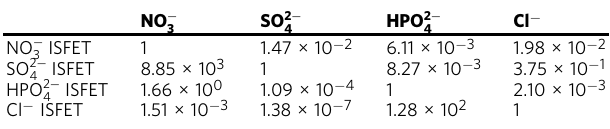
Table 3 Nikolskii selectivity coef fi cients K ij for the four anion ISFETs with respect to four anions.